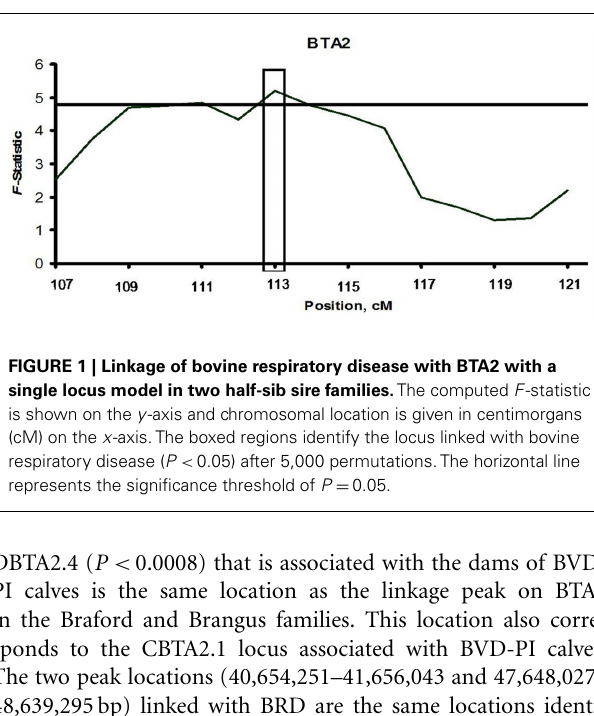
DBTA2.4 ( P < 0.0008) that is associated with the dams of BVD-